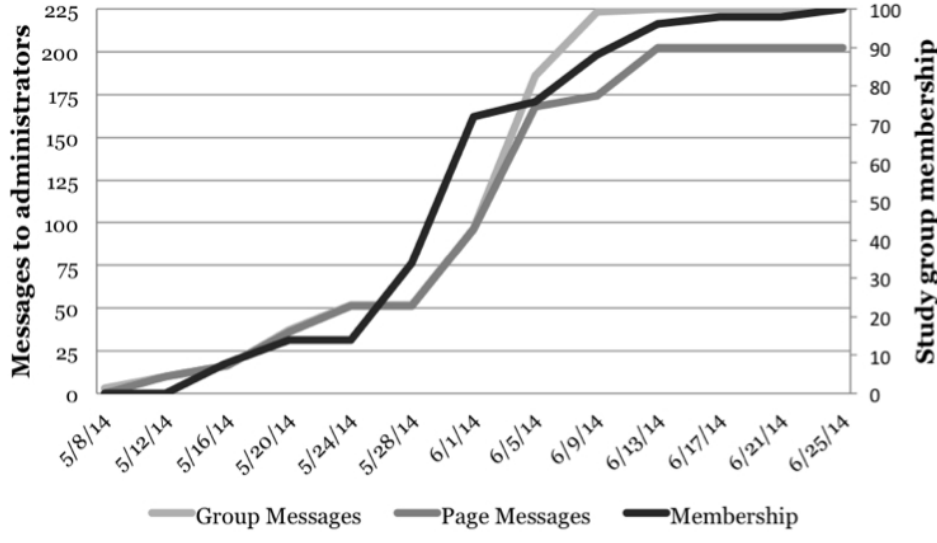
Figure 6. Study 2 cumulative Facebook study group membership over